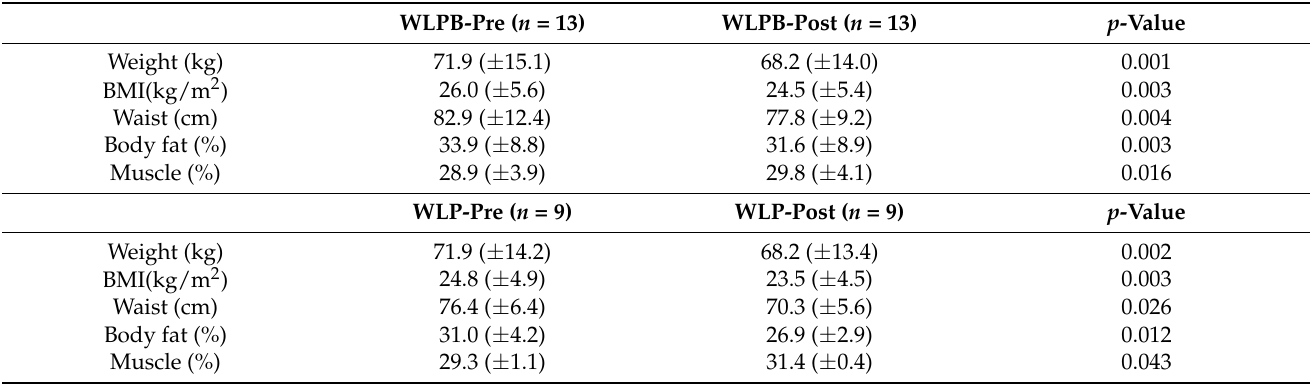
Table 1. Physical characteristics at baseline and after completing the short-term weight loss